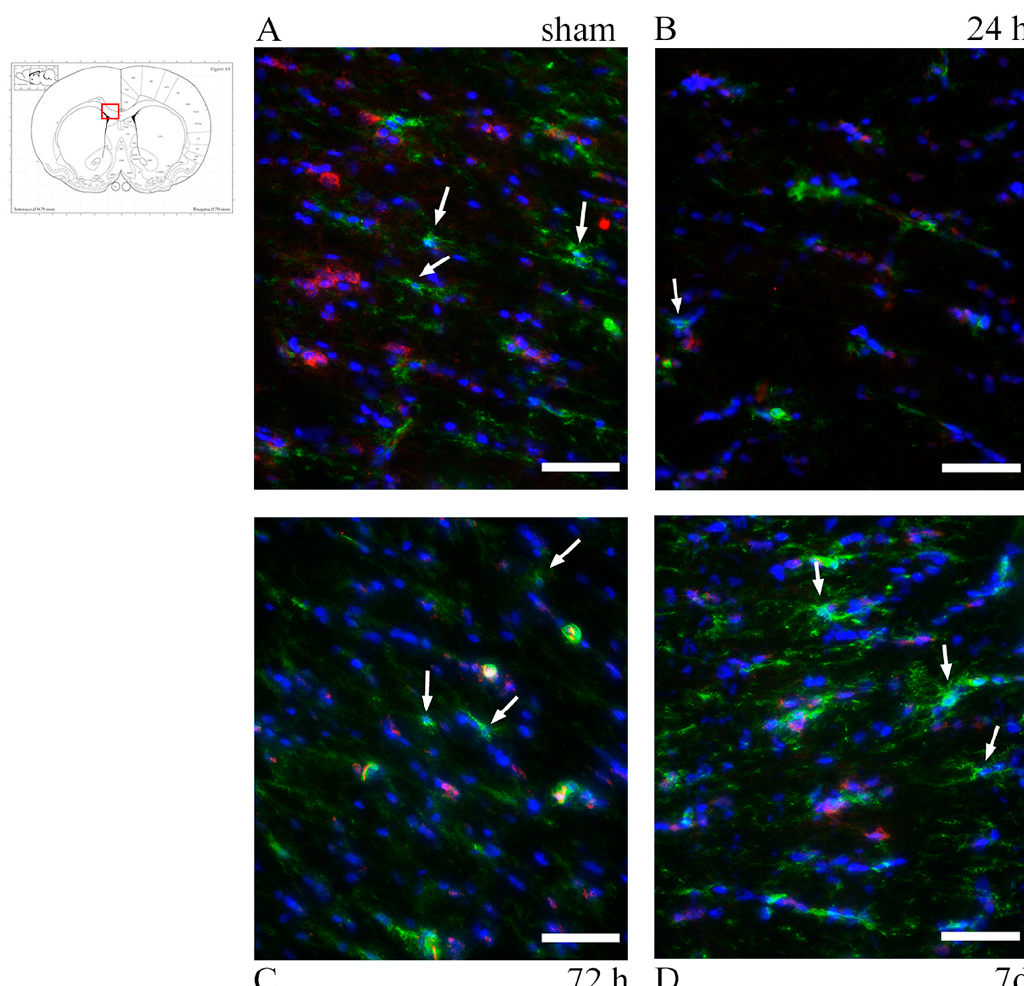
Figure 7. NG2 expression in the corpus callosum at around 1 mm from bregma. ( A – D ) Fluorescence microscopy photographs show NG2 + oligodendrocyte progenitor cells in the corpus callosum. Double staining with Occludin (red) was done to distinguish NG2 + (green) vessel walls from oligodendrocyte progenitor cells (OPCs). DAPI + nuclei are stained in blue. Arrows show NG2 +/ DAPI +/ Occludin − OPCs, which appear scattered throughout the corpus callosum, with no apparent difference between sham and trauma-exposed subjects. Insert: the highlighted area refers to the area represented in ( A – D ). Scale bar = 50 µ m.